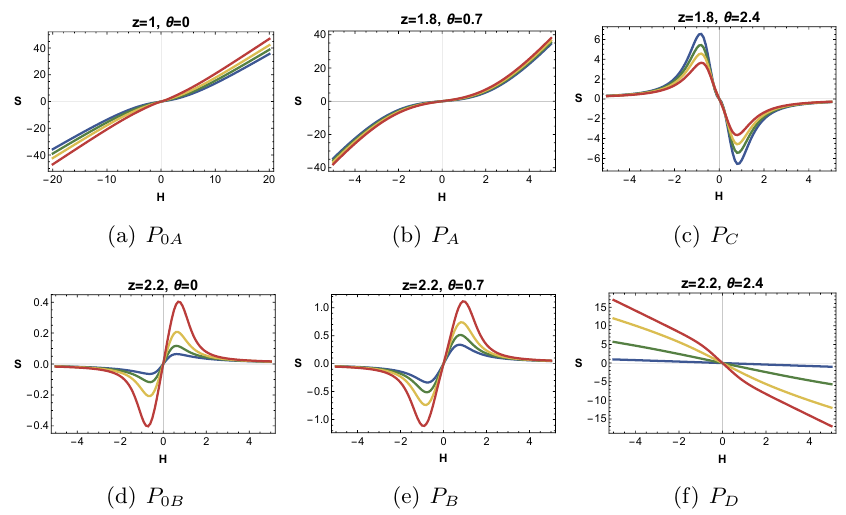
Figure 16 . Temperature evolution for S ( H ) for each region of ( z; (cid:18) ). Each curves corresponds to T = 0 : 04 ; 0 : 1 ; 0 : 16 ; 0 : 24 for blue, green, yellow, and red respectively. In all (cid:12)gure we used q (cid:31) = 0 :